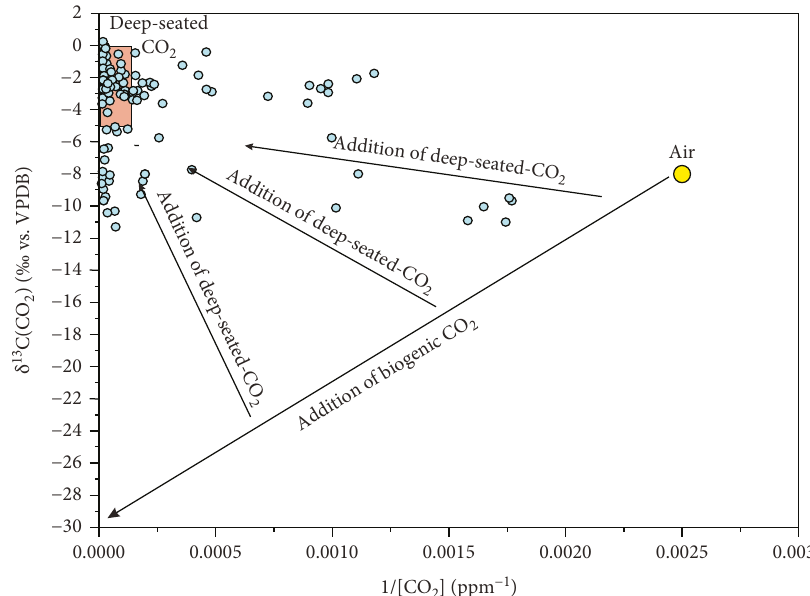
) versus 1/[CO ] (ppmV − 1 ) data from the Teide summit cone and crater. This fi gure depicts three possible 2 2 = − 8 ‰ and CO = 0 04 % , deep-seated CO 2 2 with δ 13 C CO = − 27 5 ‰ and CO = 100 % . Mixing trend between biogenic, air-derived, and deep-seated 2 2 2